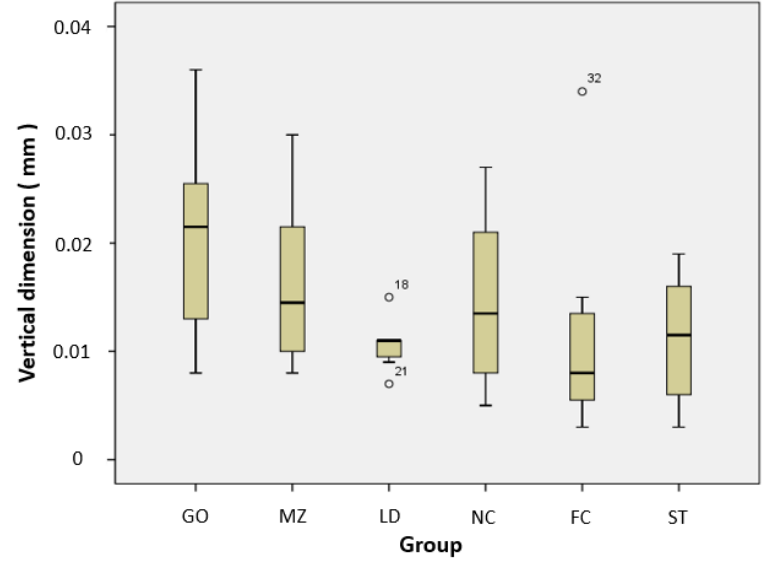
Figure 6. Vertical dimension loss distribution of restorative materials. GO, type III gold alloy group; MZ, monolithic zirconia group; LD, lithium disilicate glass ceramic group; NC, Ni–Cr alloy group; FC, feldspathic ceramic group; and ST, steatite group.